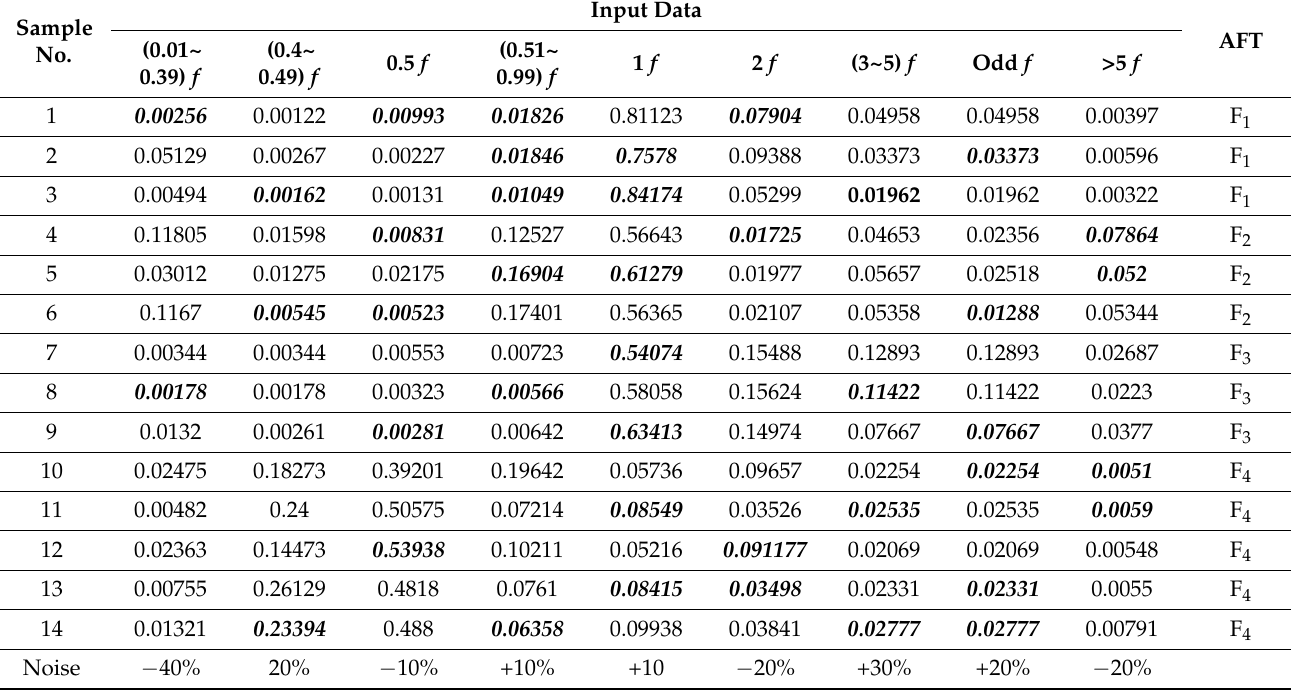
Table 5. Test Dataset for Simulation.